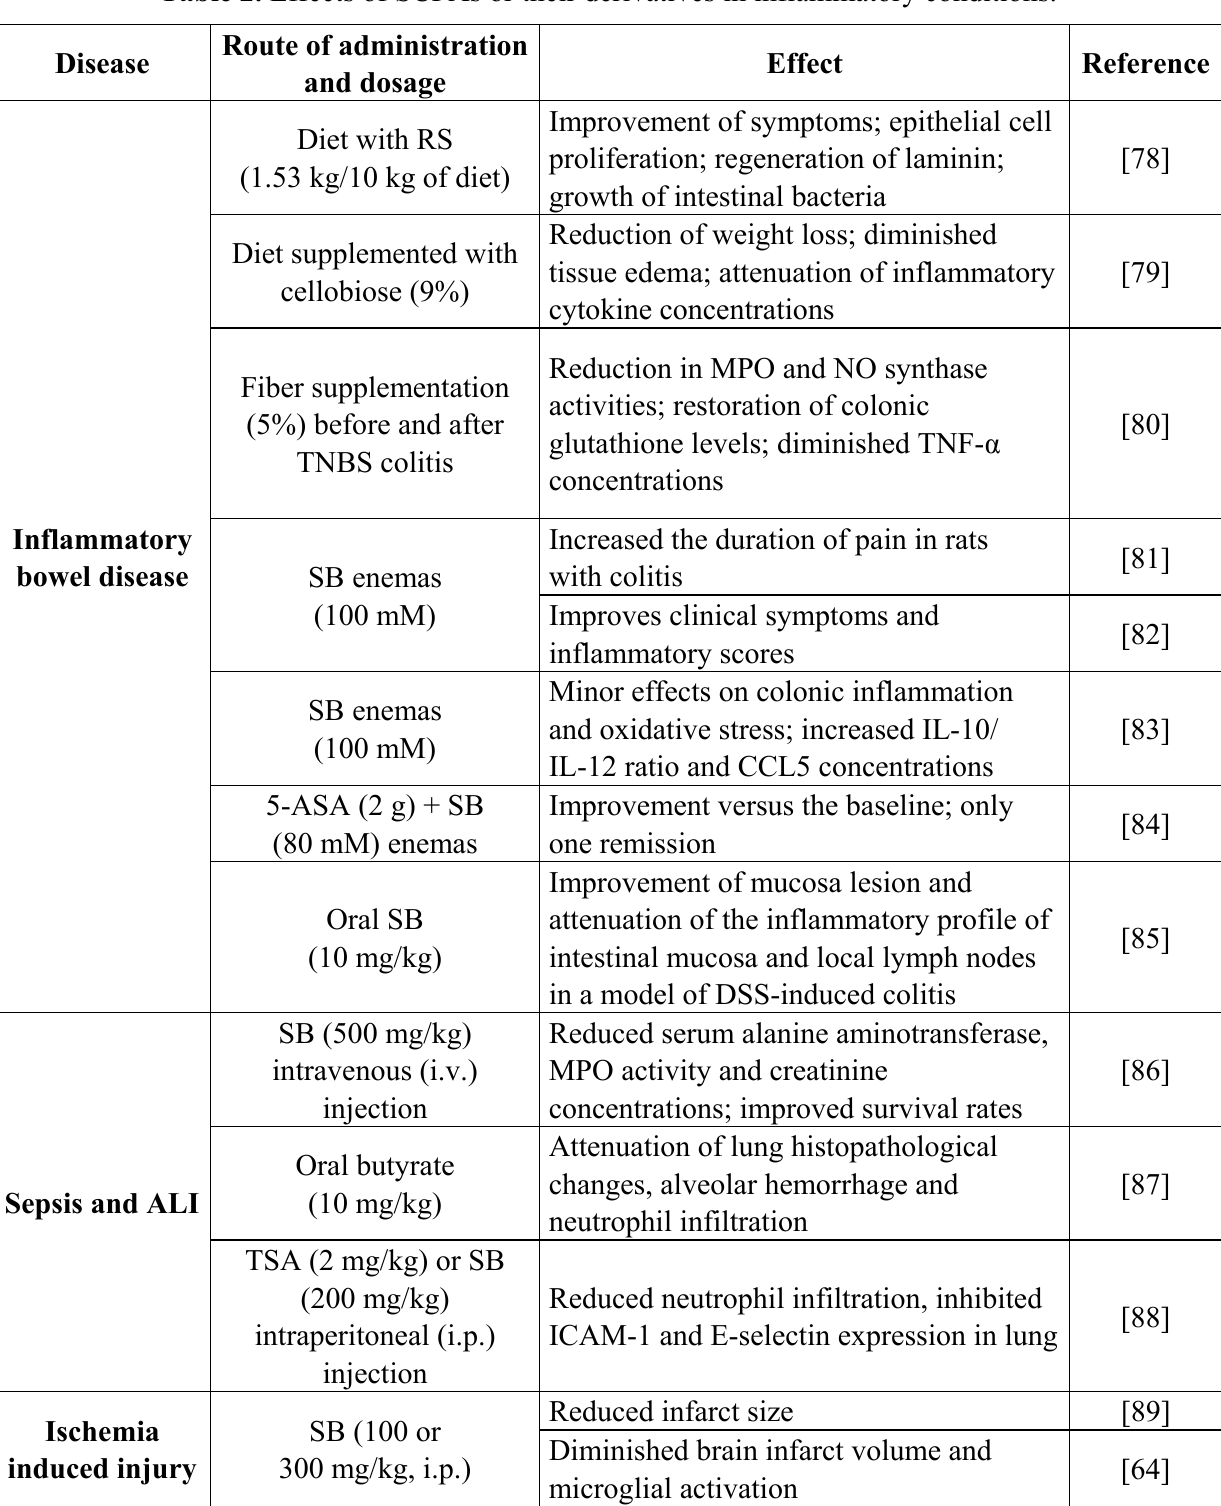
Table 2. Effects of SCFAs or their derivatives in inflammatory